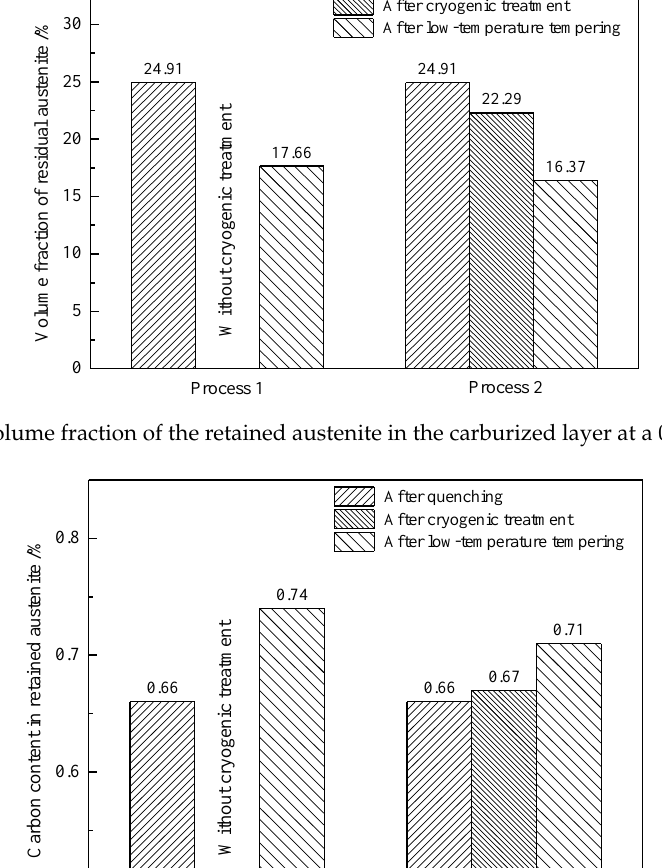
Figure 16. Carbon content of the retained austenite in the carburized layer at a 0.3 mm depth.